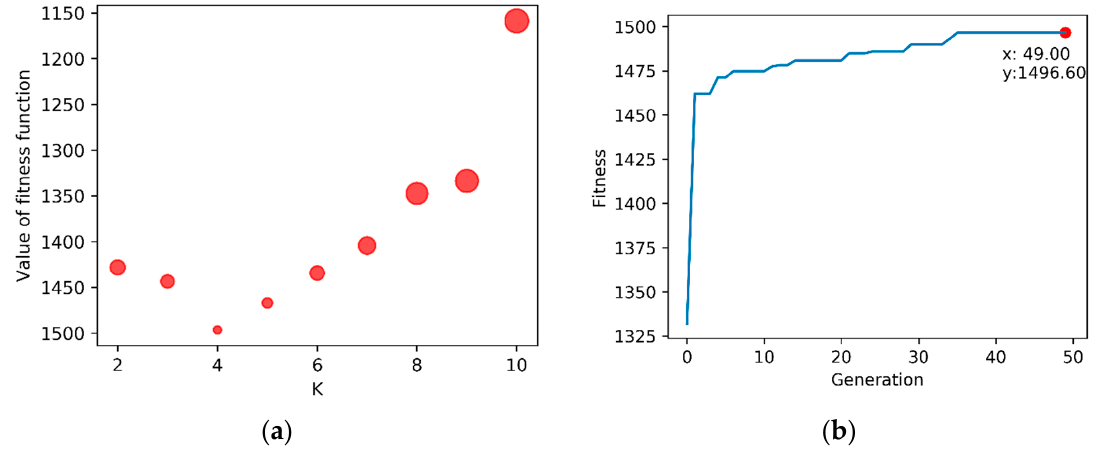
Figure 9. ( a ) The fitness value against the oil-draining frequency; ( b ) Convergence curve of the fitness value.